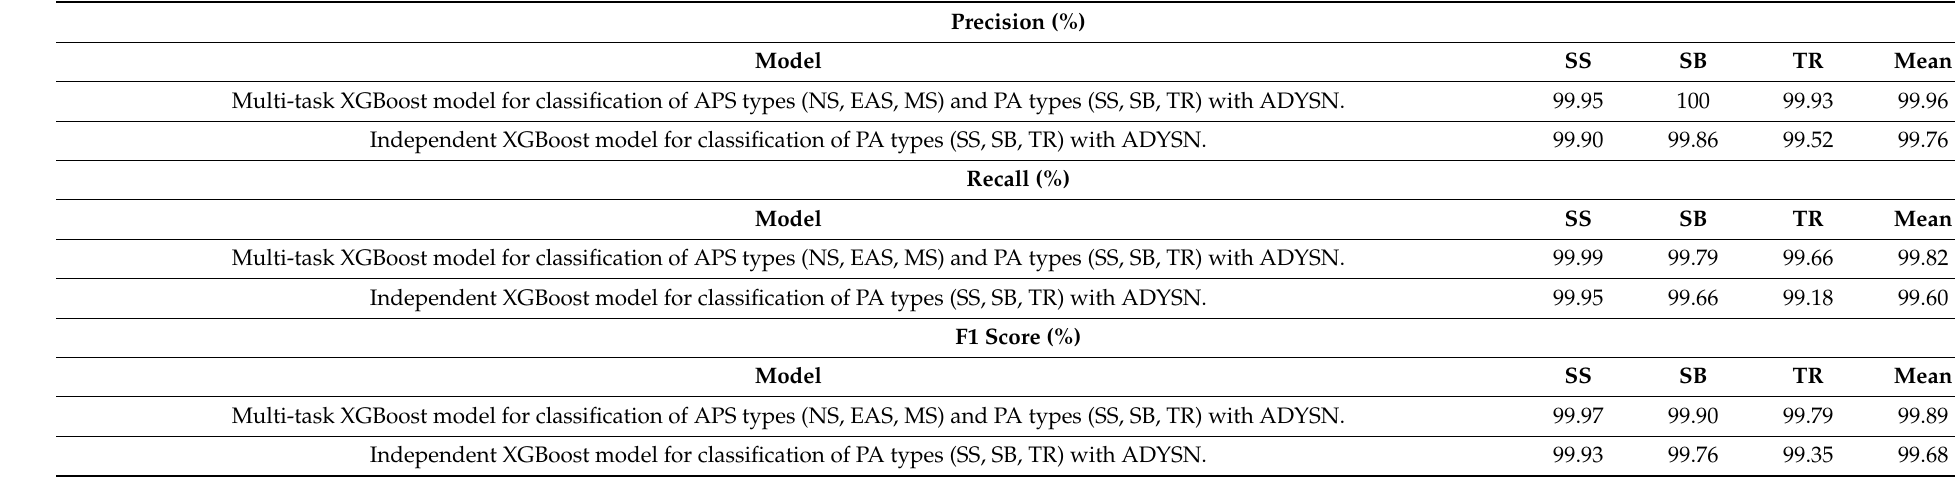
Table A3. Precision, Recall, and F1 score for PA Classification (XGBoost models).